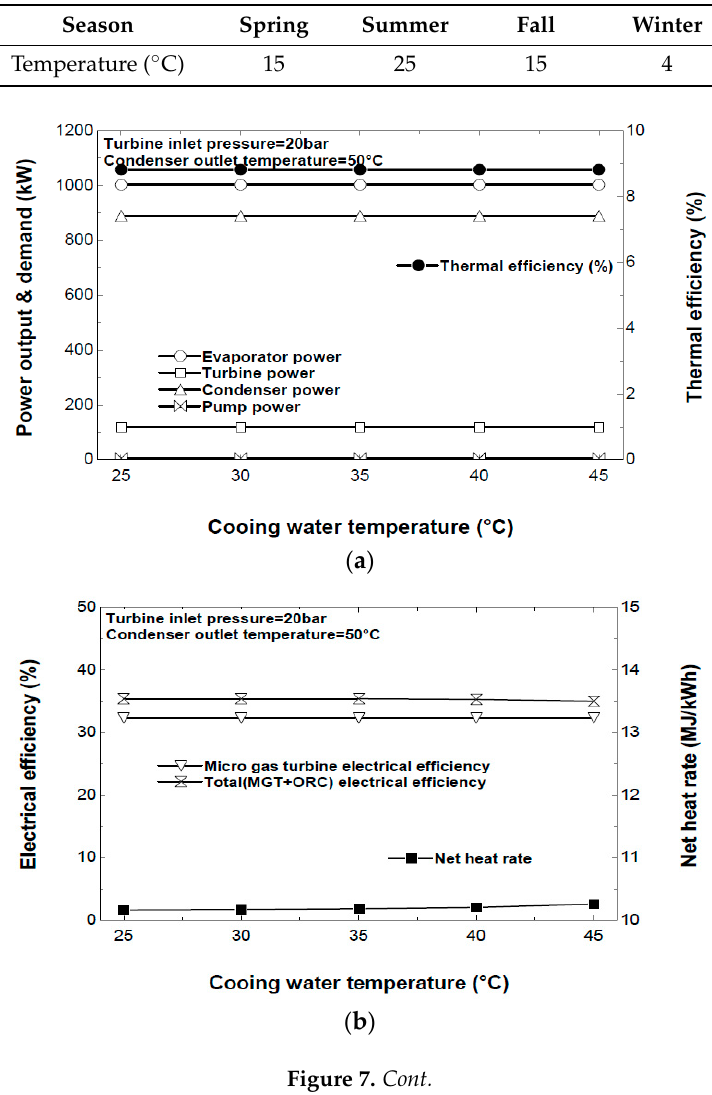
Table 7. Tmperature of sewage sludge and food waste in Busan, Republic of Korea.